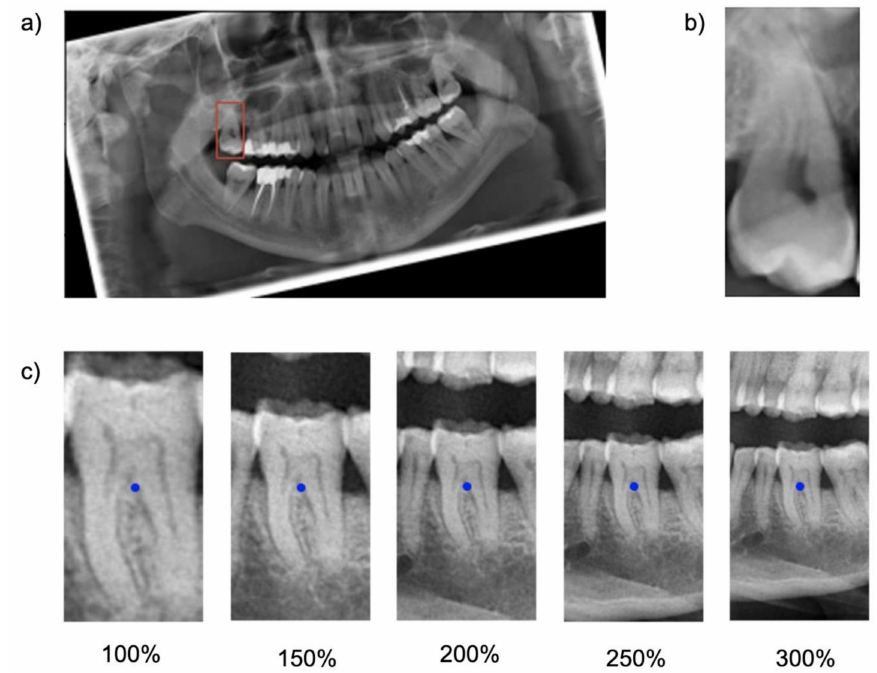
Figure 1. Visualization of data preparation steps. ( a ) Panoramic radiograph with an annotated bounding box around one tooth. The image is rotated as required by the cropping algorithm, which extracts the image segment captured by the bounding box. ( b ) Baseline size (100%) of the image segment covering the area captured of the bounding box. ( c ) Visualization of increasing image segment sizes from left to right. 100% captured image segments with the size of the annotation bounding box. 300% covered image segments with the size of the bounding box upscaled by a factor of